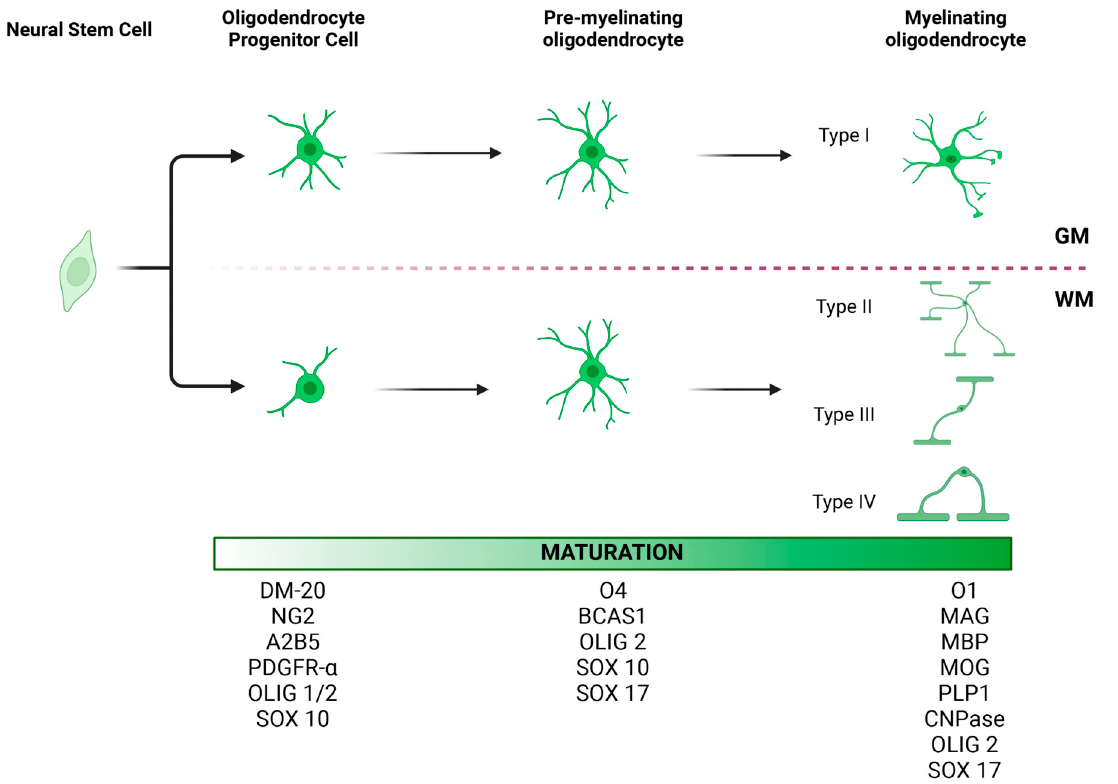
Figure 1. Morphology and maturation of oligodendrocyte lineage cells (OLCs). At least three stages of oligodendrocyte differentiation have been described: oligodendrocyte progenitor cells (OPCs), pre-myelinating oligodendrocytes, and mature myelinating oligodendrocytes. Each stage is characterized by the expression of certain protein markers, which may be useful in identifying these cell types in the brain tissue. OLCs also vary in morphology depending on their location. OPCs in gray matter tend to have radial processes. In contrast, OPCs in white matter tend to have processes parallel to axonal fibers. Accordingly, four different types of oligodendrocytes have been described, with Type I oligodendrocytes being the most dominant in the gray matter and Type II oligodendrocytes in the white matter [67,68]. While the location of Type III and IV oligodendrocytes has not been well characterized, we hypothesize that given their morphology and longitudinal processes, they too are most commonly seen in the white matter. GM, gray matter; WM, white matter. This figure was created with BioRender.com.